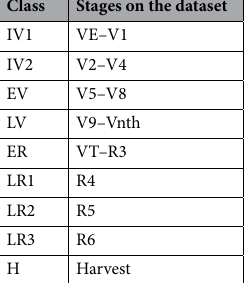
Table 1. Phenology classes (IV1-H) after re-grouping the phenological stages (VE–R6). IV1 initial vegetative 1, IV2 initial vegetative 2, EV early vegetative, LV late vegetative, ER early reproductive, LR1 late reproductive 1, LR2 late reproductive 2, LR3 late reproductive 3, H